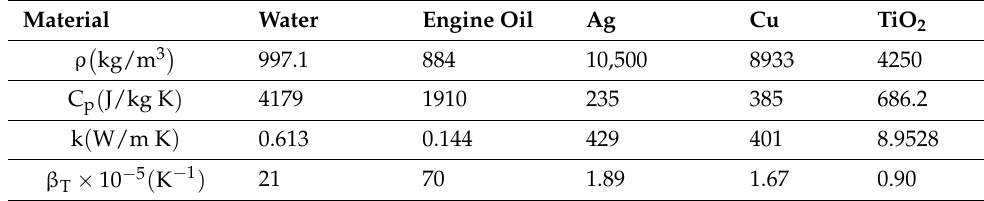
Table 2. The thermal features of nanoparticles and regular fluids. Material